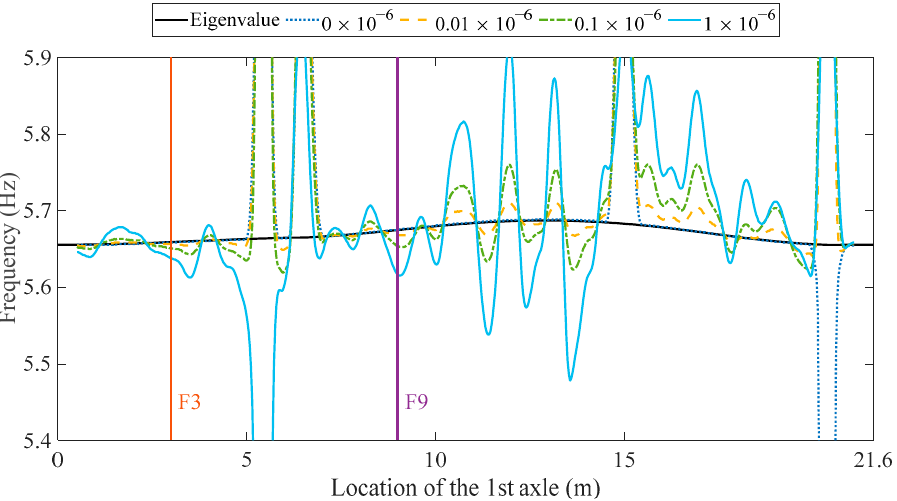
Figure 10. Comparison of the eigenvalue curve and the STFT of the undamped bridge response due to the truck travelling at 1 m/s on four roads with different roughness coefficients.